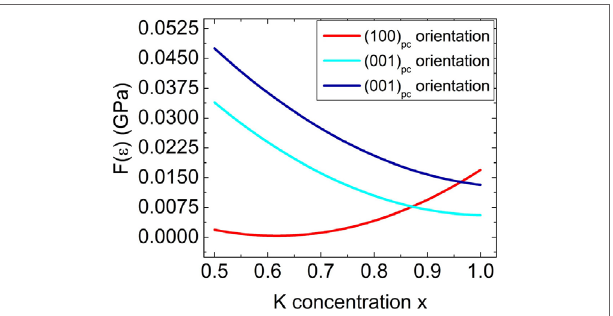
FigUre 7 | Calculated elastic strain energy density F( ε ) of K x Na 1 − x NbO 3 thin films grown on (110) NdScO 3 substrates as a function of the film composition x ( x = 0.5 − 1). Thereby the two different surface orientations—(100) pc (red curve) and (001) pc (blue and cyan curve)—have to be considered.